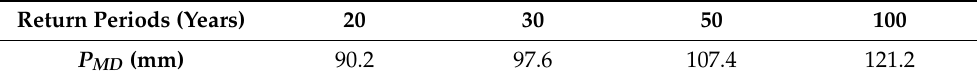
Table 3. Annual P MD values estimated by the Gumbel type II model for the selected return